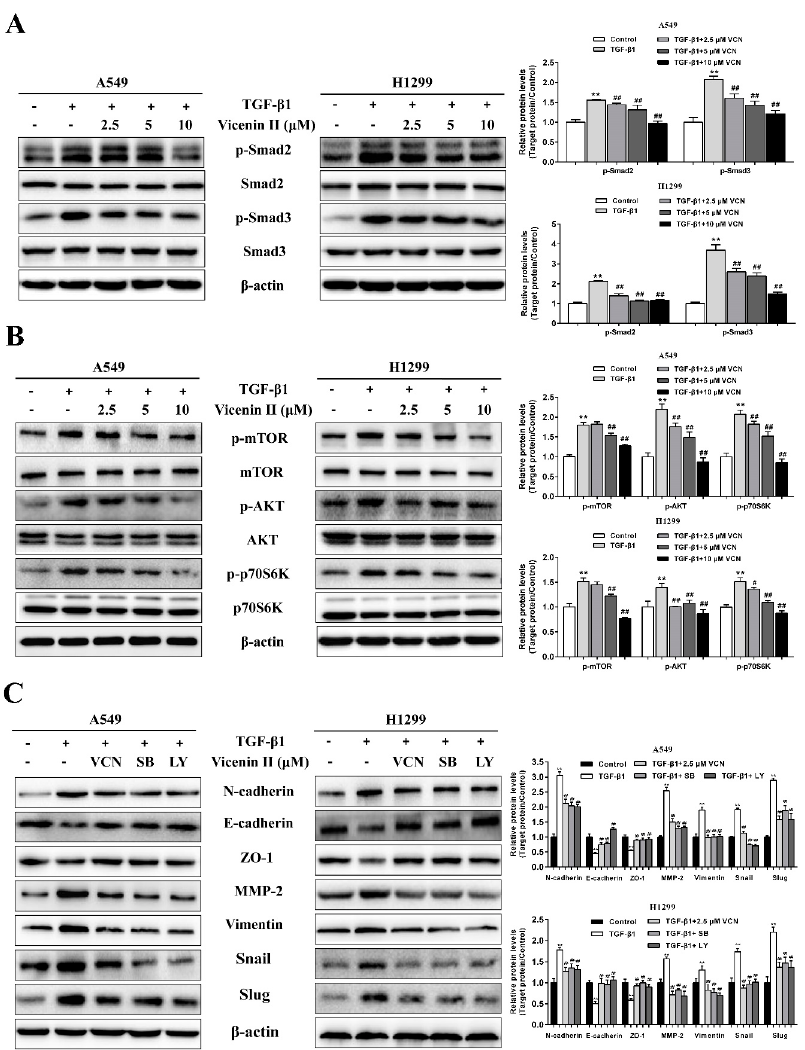
Figure 6. Effects of ViceninII on the TGF- β /Smad and PI3K/Akt/mTOR pathways in A549 and H1299 cells. ( A ) Cells were treated with 5 ng/mL of TGF- β 1 for 48 h, during which the indicated concentrations of ViceninII were added for the last 24 h. The expression of TGF- β /Smad related pathway proteins, including p-Smad2, Smad2, p-Smad3, and Smad3, was examined by western blot analysis. ( B ) The expression of PI3K/Akt/mTOR related pathway proteins, such as p-Akt, Akt, p-mTOR, mTOR, p-P70S6K and P70S6K, was detected by western blot analysis. It was reconfirmed that ViceninII suppresses TGF- β 1-induced EMT in A549 and H1299 cells through regulation of the TGF- β /Smad and PI3K/Akt/mTOR pathways. ( C ) Cells were pre-treated with 5 ng/mL TGF- β 1 for 48 h and then treated with 10 µ M ViceninII, 20 µ M SB431542 (SB, TGF- β /Smad inhibitor) or 20 µ M LY294002 (LY, PI3K/Akt inhibitor) for the last 24 h. Then, using western blot, the protein expression of E-cadherin, ZO-1, N-cadherin, MMP-2, vimentin, snail, and slug was analyzed. β -actin was used as a loading control. Typical graphs and a histogram (mean ± SD) are shown, n = 3. ** p < 0.01 compared with the control group; ## p < 0.01 compared with the TGF- β 1-treated